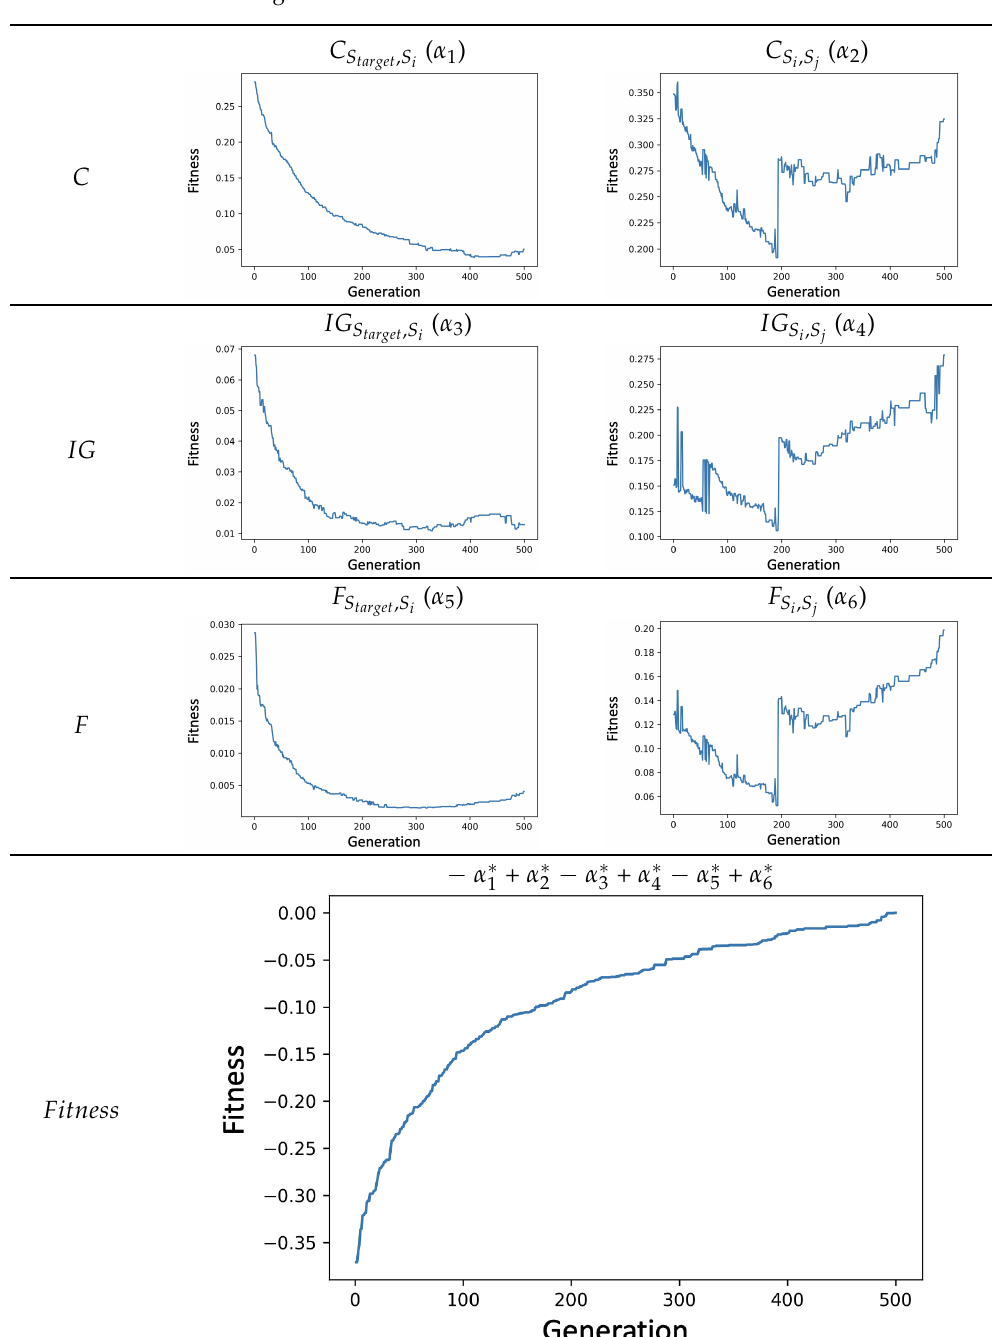
Table 2. The fitness of our genetic filter from 2015 to